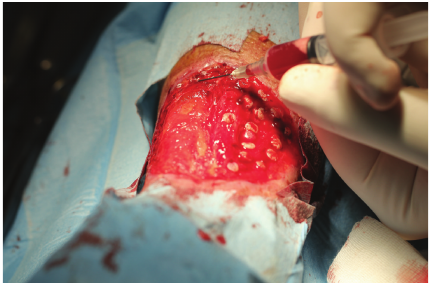
Figure 3: The platelet-rich plasma has been infiltrated on the bot- tom of the punch graft and edges of the